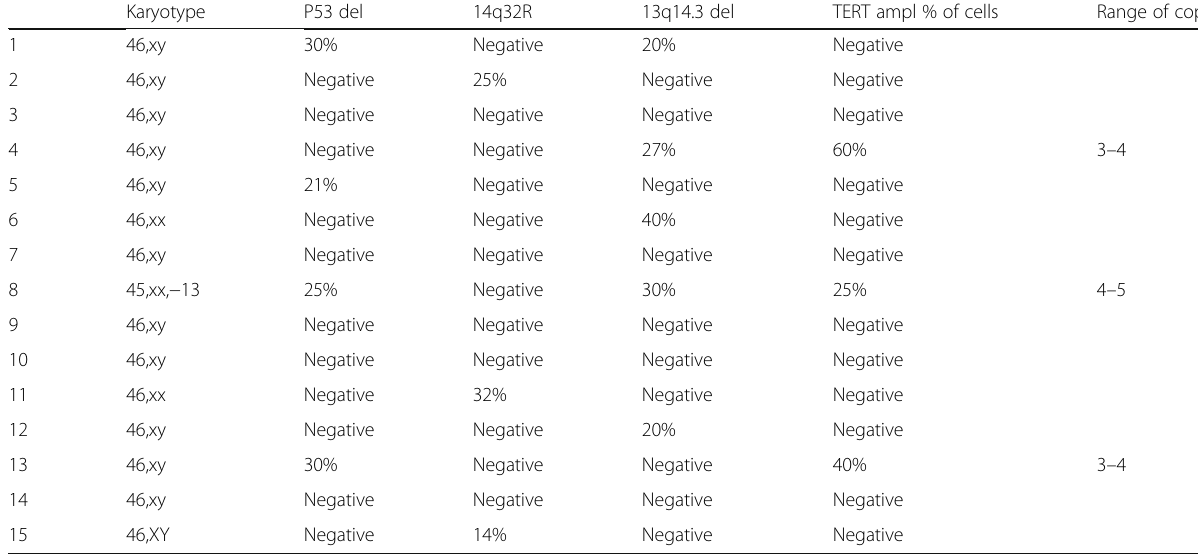
Table 2 Cytogenetics results of multiple myeloma patients (group I)